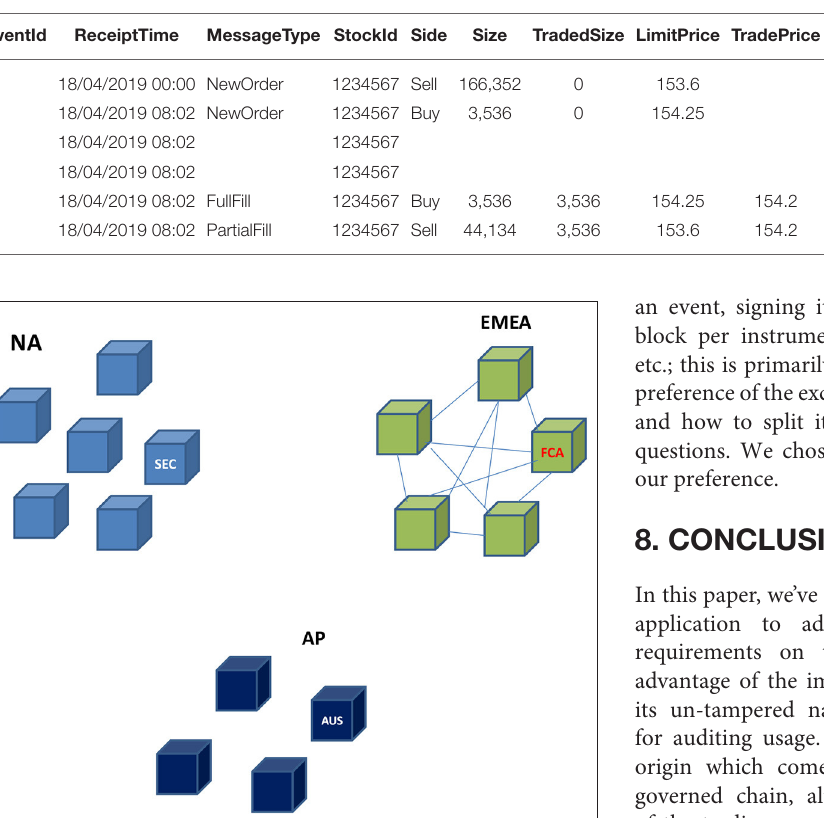
TABLE 2 | Sample stream of events on one node.